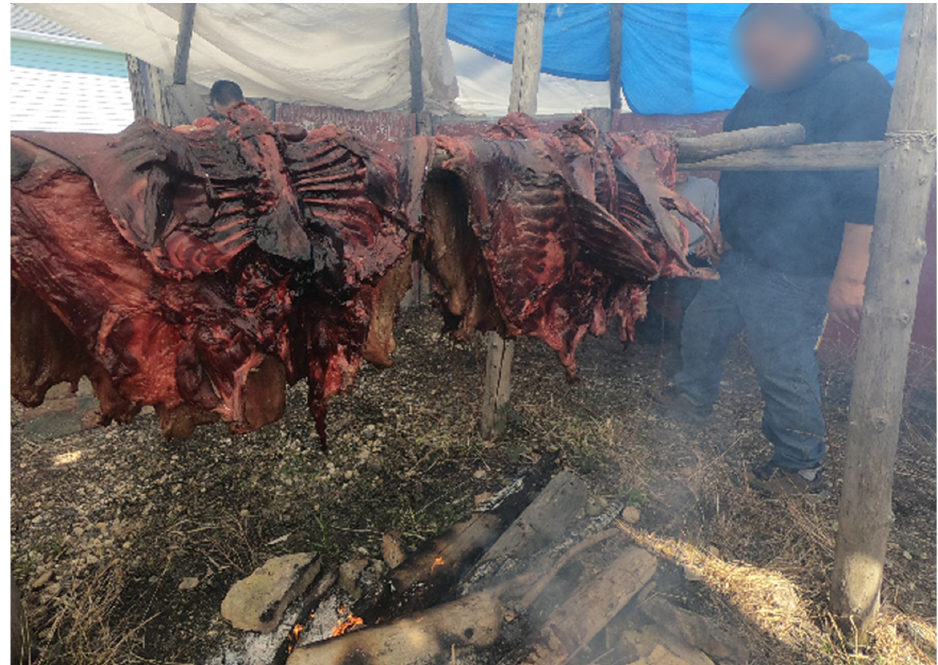
Figure 4. Beaver meat being prepared by an on-the-land expert using traditional methods of smok-